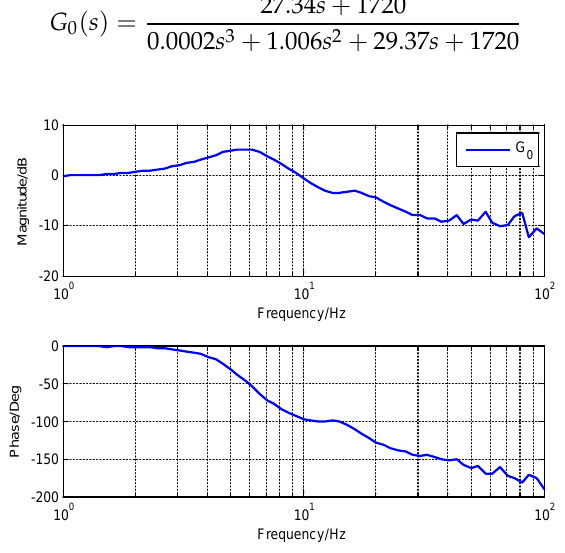
Figure 12. The open-loop external disturbance transfer function.